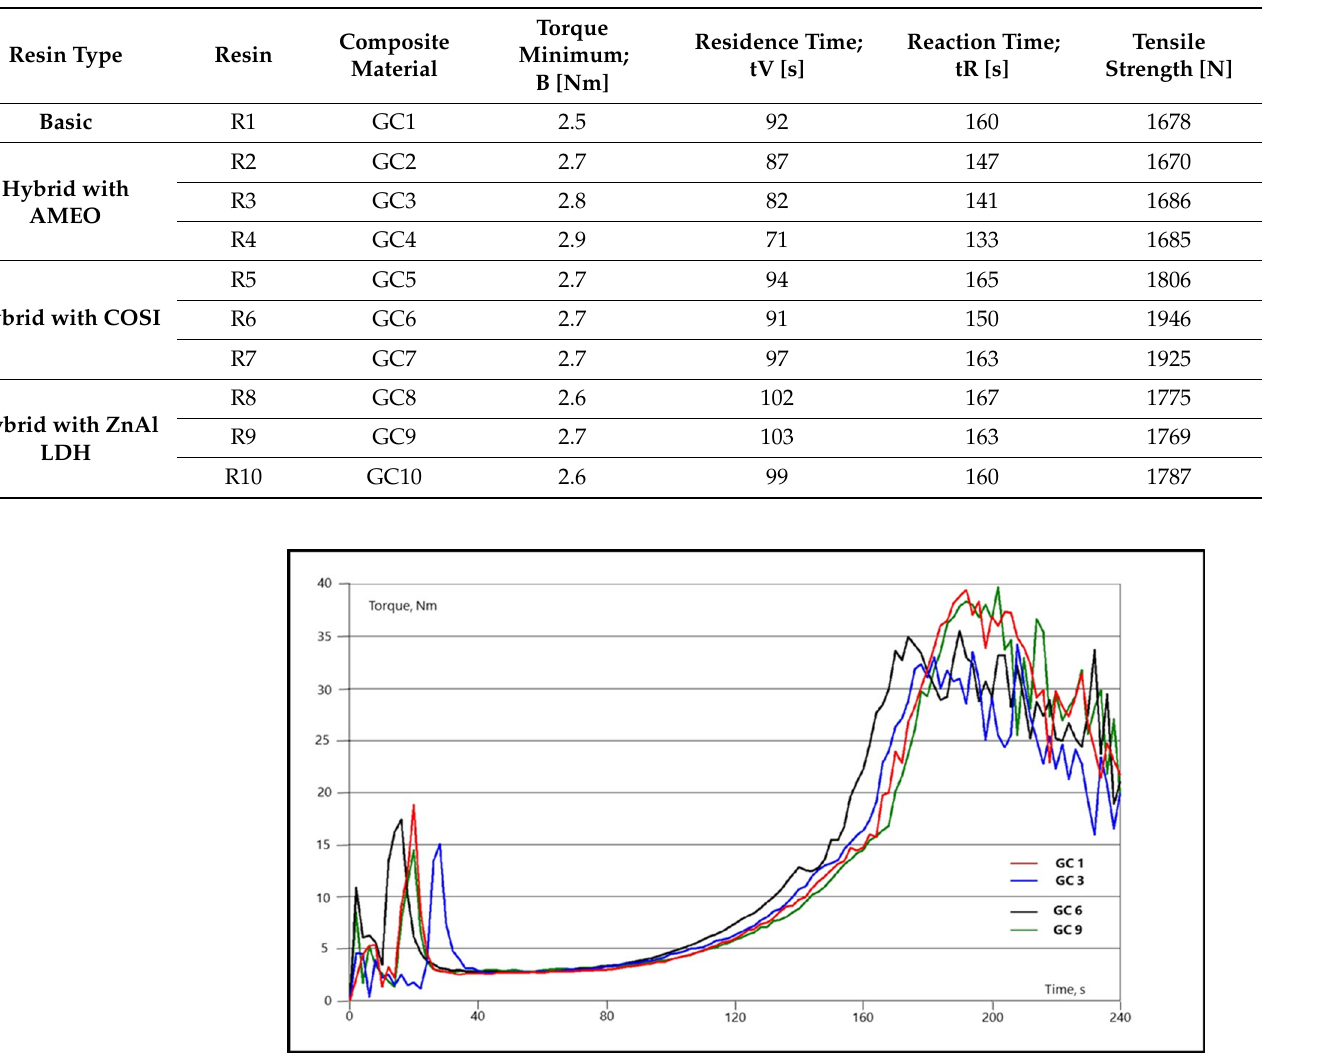
Figure 5. Examples of flow-curing behaviors of some prepared GC composites.